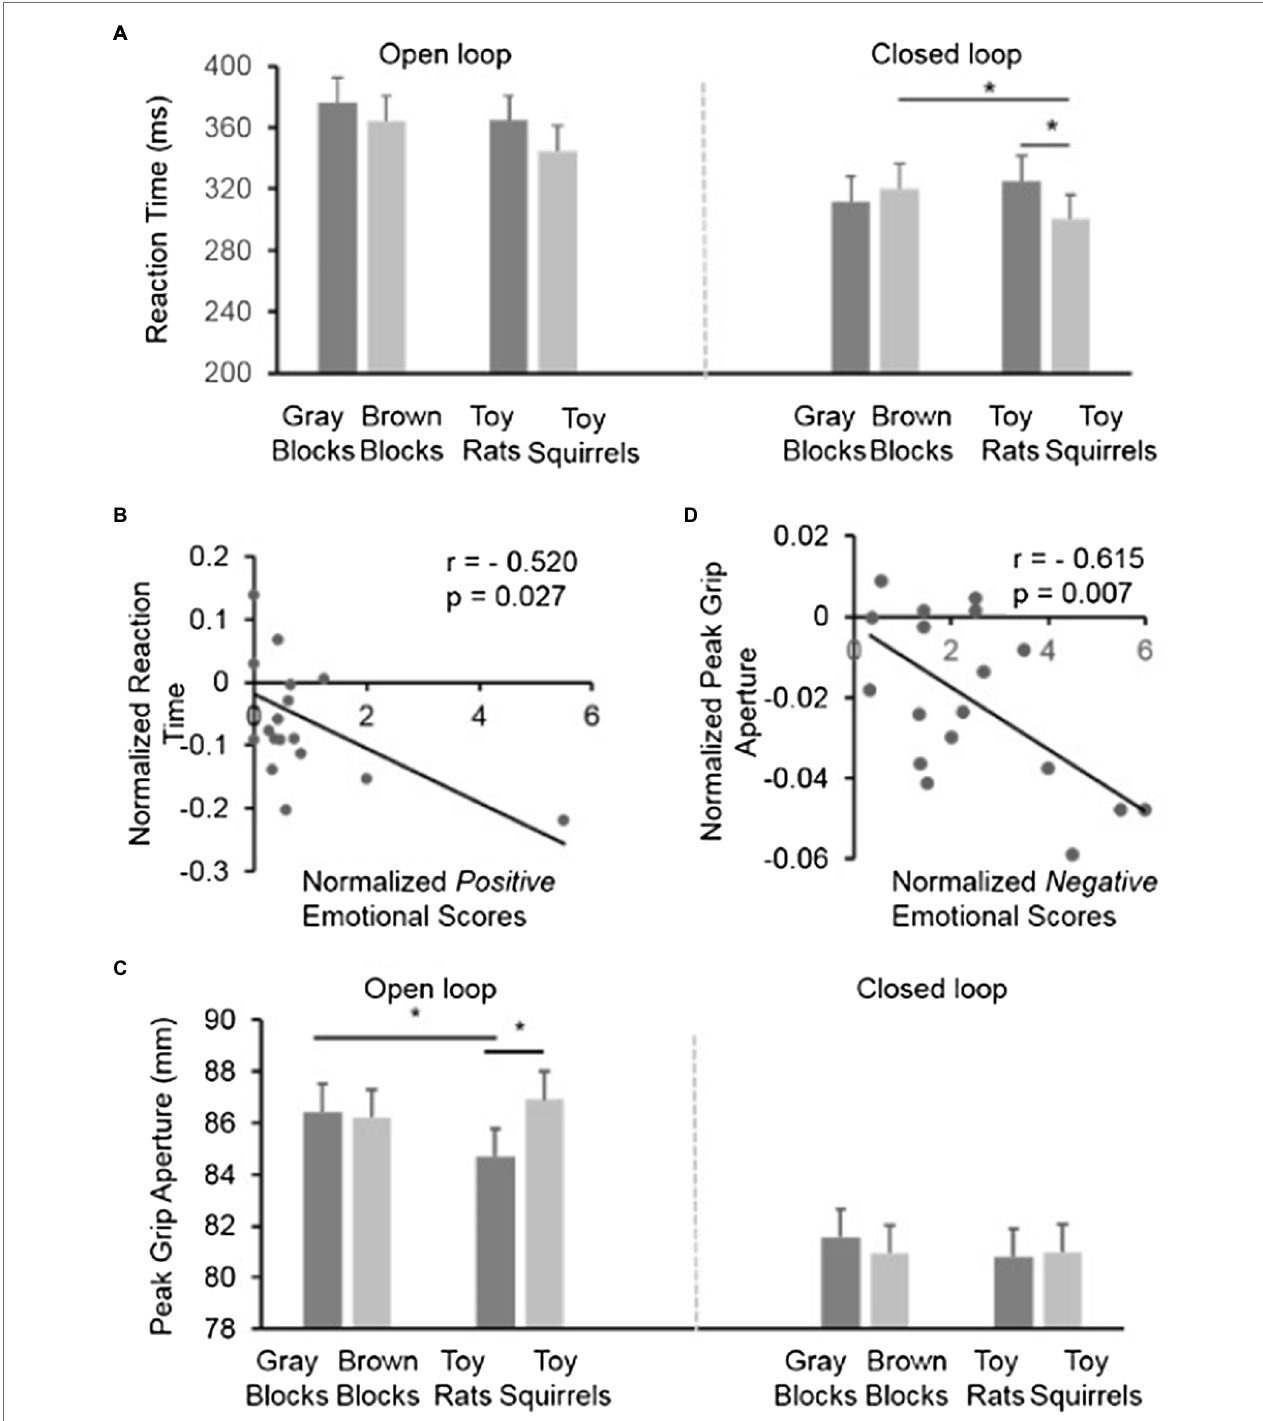
FIGURE 4 | The results in Experiment 2. (A) The reaction time in the control conditions (gray blocks and brown blocks) and the experimental conditions (toy rats and toy squirrels) when participants had no visual feedback (open-loop) or had visual feedback (closed-loop) during the execution of grasping. (B) The correlation between the normalized positive emotional scores and the normalized reaction time in the closed-loop condition across individuals. Note, although there seems an outlier, the correlation was still strong after the “outlier” was removed. In other words, the correlation could not be attributed to the existence of the “outlier.” (C) The peak grip apertures (PGAs) during grasping in the control conditions (gray blocks and brown blocks) and the experimental conditions (toy rats and toy squirrels) when participants had no visual feedback (open-loop) or had visual feedback (closed-loop) during the execution of grasping. (D) The correlation between the normalized negative emotional scores and the normalized peak grip aperture in the open-loop condition across